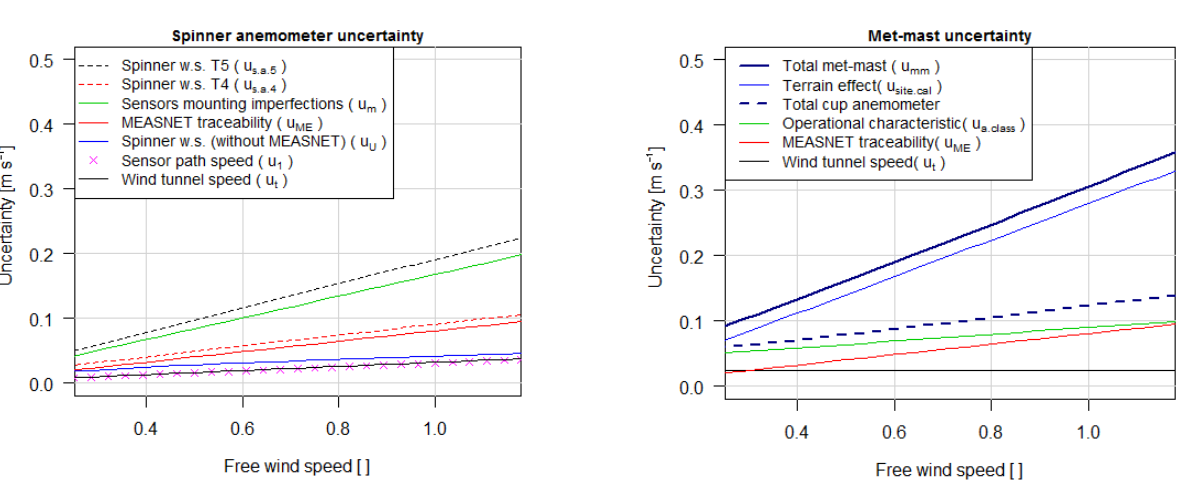
Figure 17. Overview of the size of the various uncertainty compo- nents and total